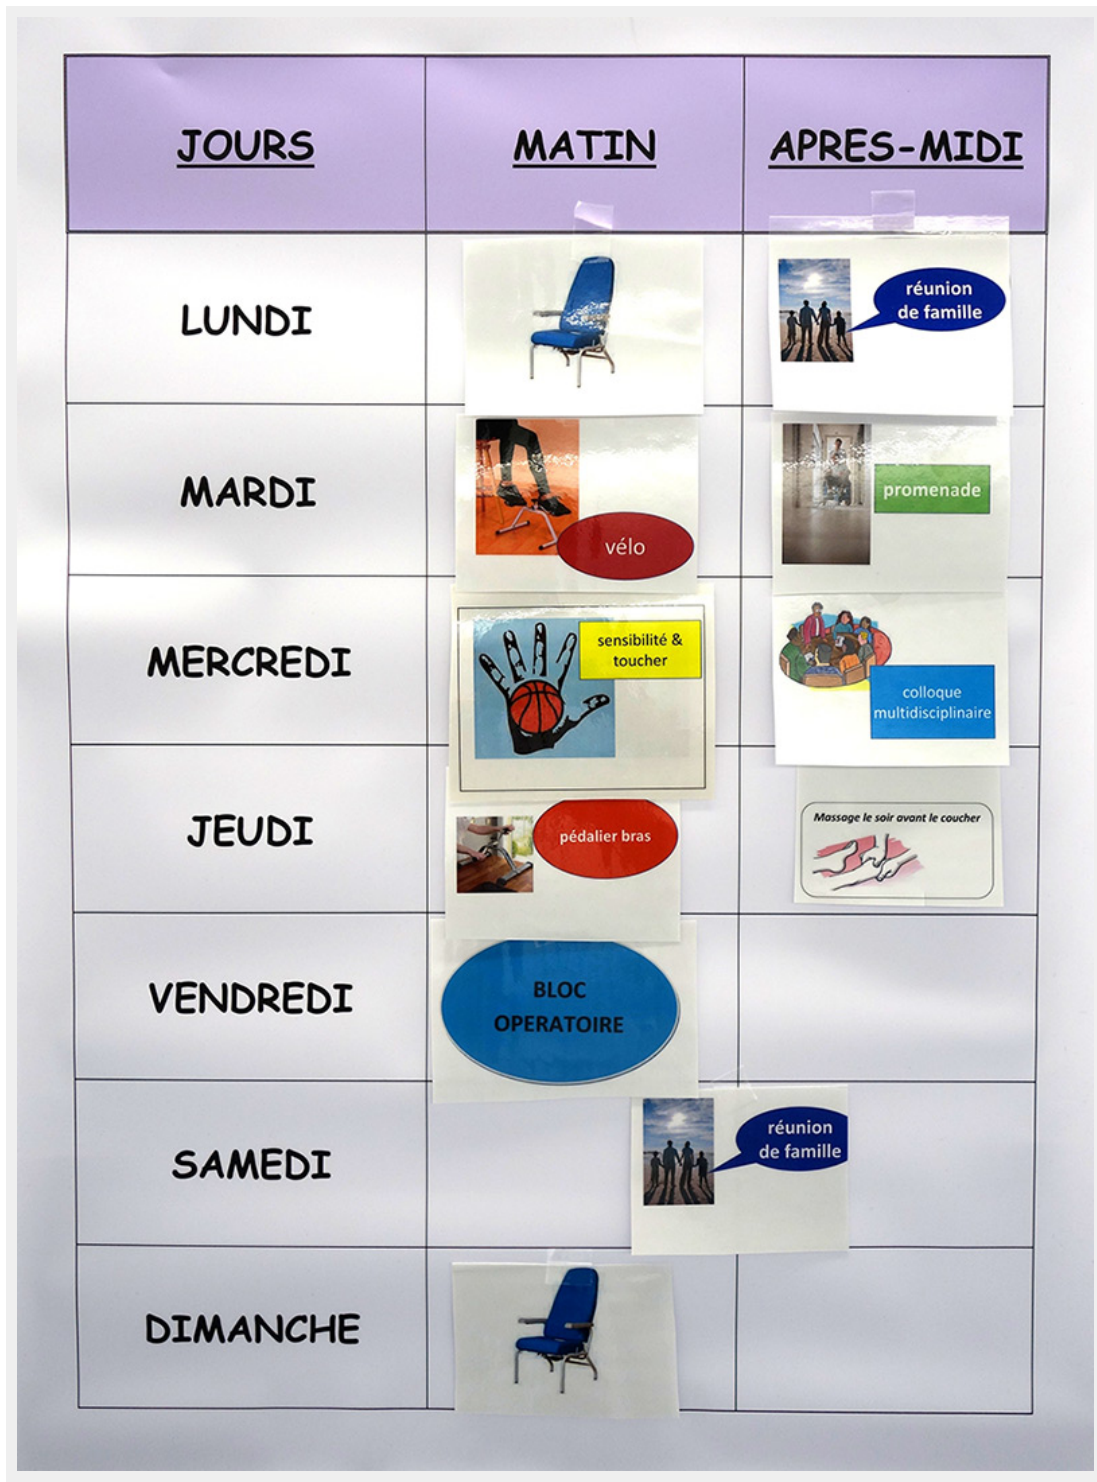
Figure 2 Poster showing the weekly schedule on the bedside of a PLS. Jours = days; matin = morning; après-midi = afternoon; lundi = Monday; mardi = Tuesday; mecredi; Wednesday; jeudi = Thursday; vendredi = Friday; samedi = Saturday; dimanche =